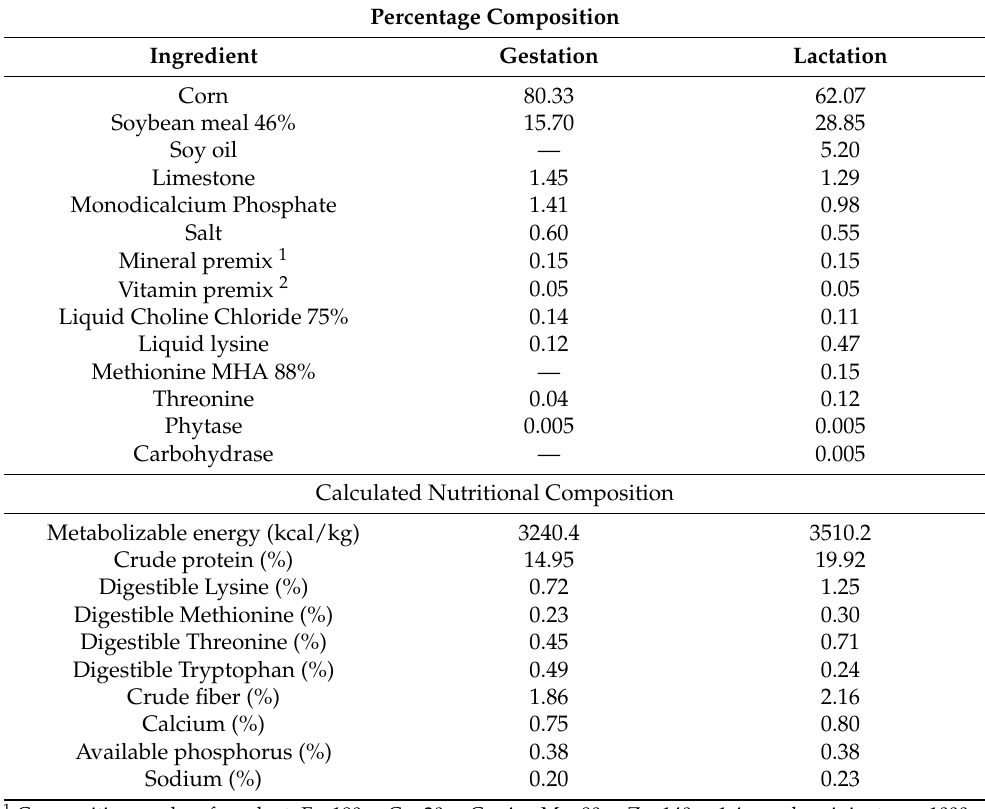
Table 1. Percentage and calculated nutritional composition of experimental diets during the phases of gestation and